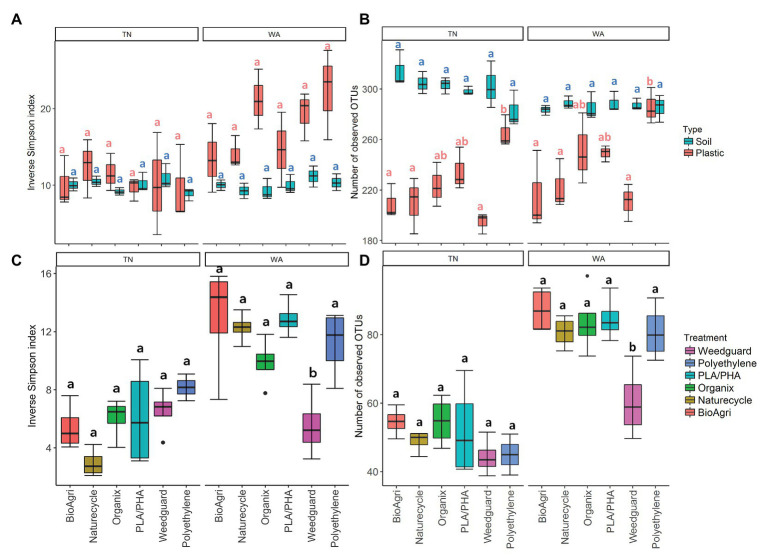
(A) Diversity (inverse Simpson Index) and (B) richness (number of observed OTUs) of bacterial communities on agriculturally-weathered BDMs and bulk soil in TN and WA. (C) Diversity (inverse Simpson Index) and (D) richness (number of observed OTUs) of eukaryotic communities on agriculturally-weathered BDMs in TN and WA. The lower and upper hinges of the boxplots correspond to the 25th and 75th percentile and the middle of the box denotes the median at 50th percentile. Whiskers denote 1.5 times the inter-quartile range. Letters indicate Tukey post hoc results following a one-way ANOVA. All significances tested at α = 0.05.